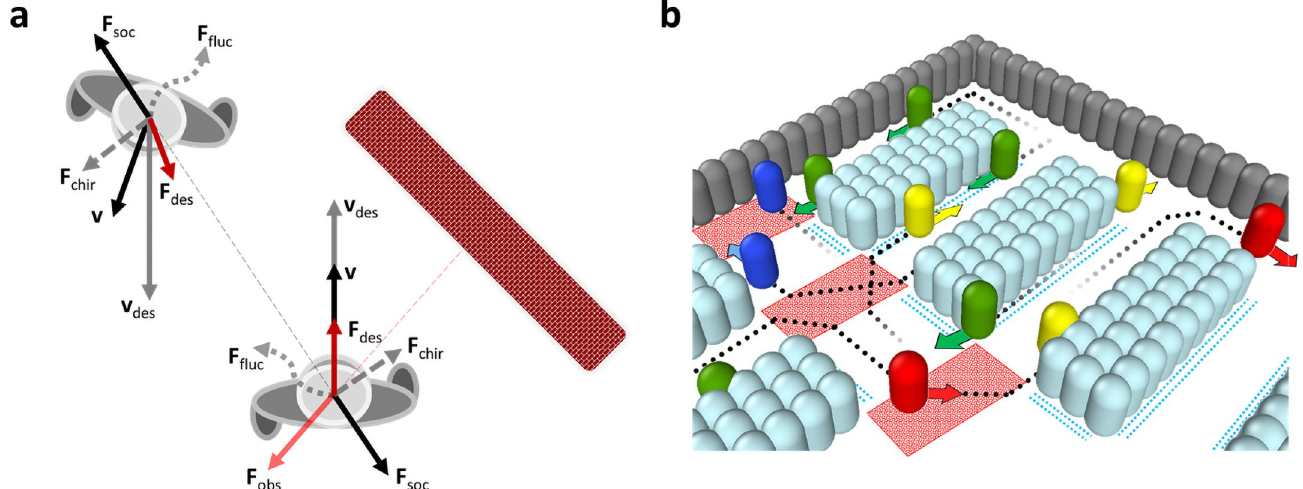
Fig 1. Illustration of the components of the composite mode: (a) Social force model—a schematic diagram of the terms of Eq (2). (b) Sketch of the customers strategy—the behavior in the crossroad zones and near shelves. The examples of the desired (not actual) trajectories are shown. The notations are: red area— crossroad zone, blue dashes—slow motion zone (near the shelves). Gray cylinders indicate walls, light-blue—shelves with goods. The colour of visitor (cylinders) encodes the desired direction of motion: North (blue), South (red), East (yellow), and West (green), see also S1 Appendix.